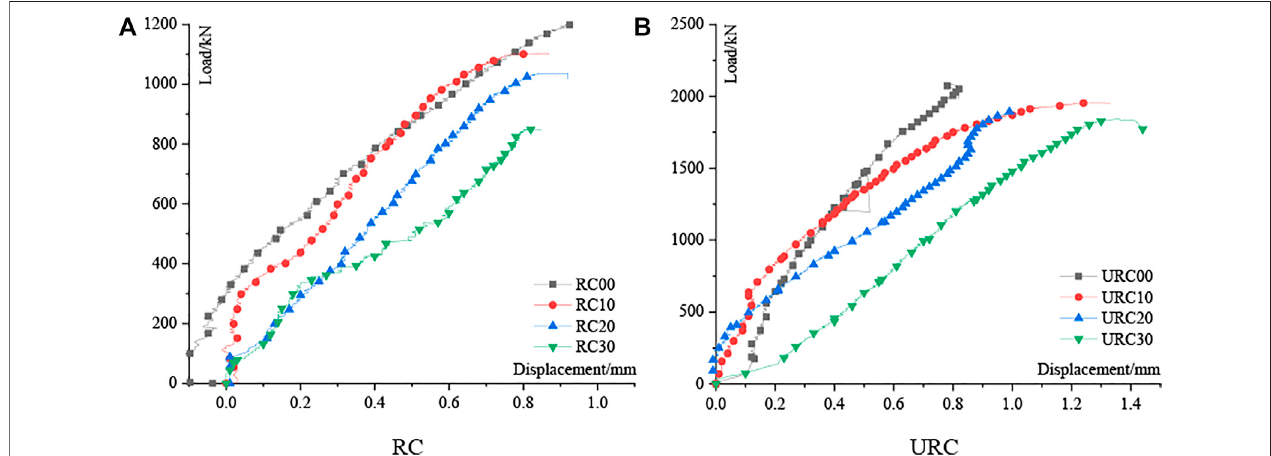
FIGURE 7 | Load-displacement of the specimen. (A) RC. (B) URC.